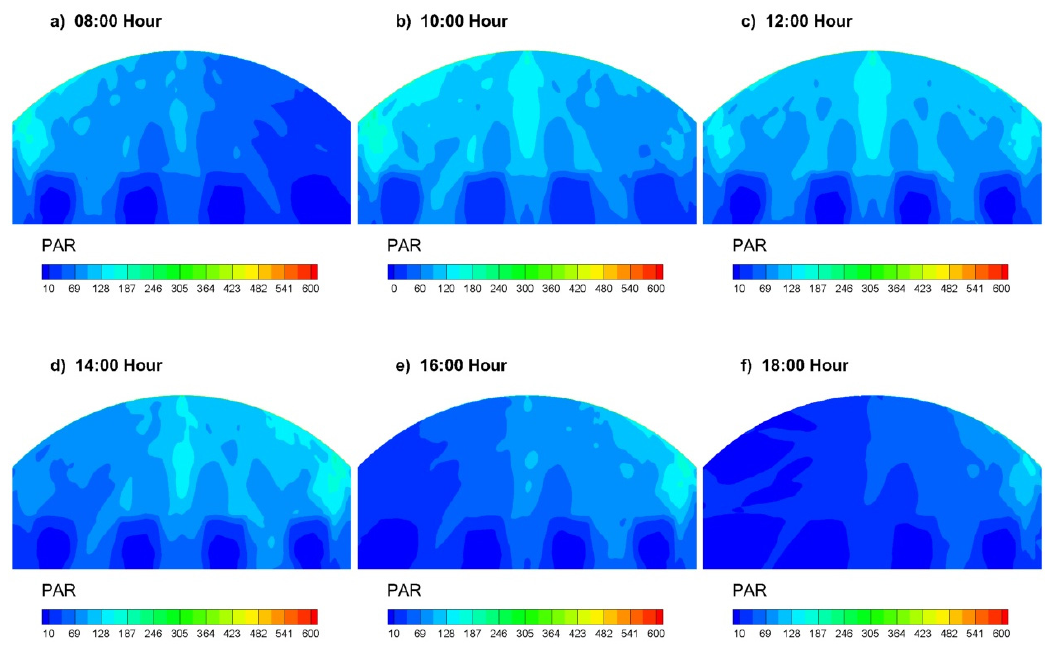
Figure 4. PAR isocontours for 21 June and τ n,PAR =45%.